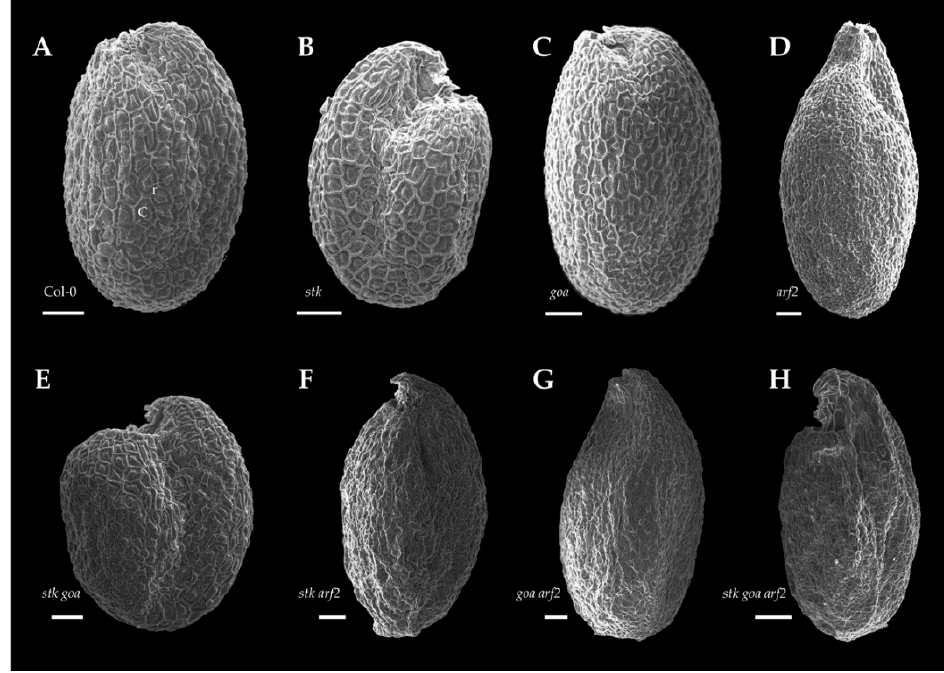
Figure 5. Scanning electron microscopy of seeds. SEM imaging of mature seeds. ( A ) Wild type Col-0 epidermal seed coat cells have hexagonal shape with a clear radial cell wall and columella. The seed coat epidermal cell morphology of stk ( B ), goa ( C ) and stk goa ( E ) is very similar to wild type ones. On the contrary, arf2 ( D ), stk arf2 ( F ), goa arf2 ( G ) and stk goa arf2